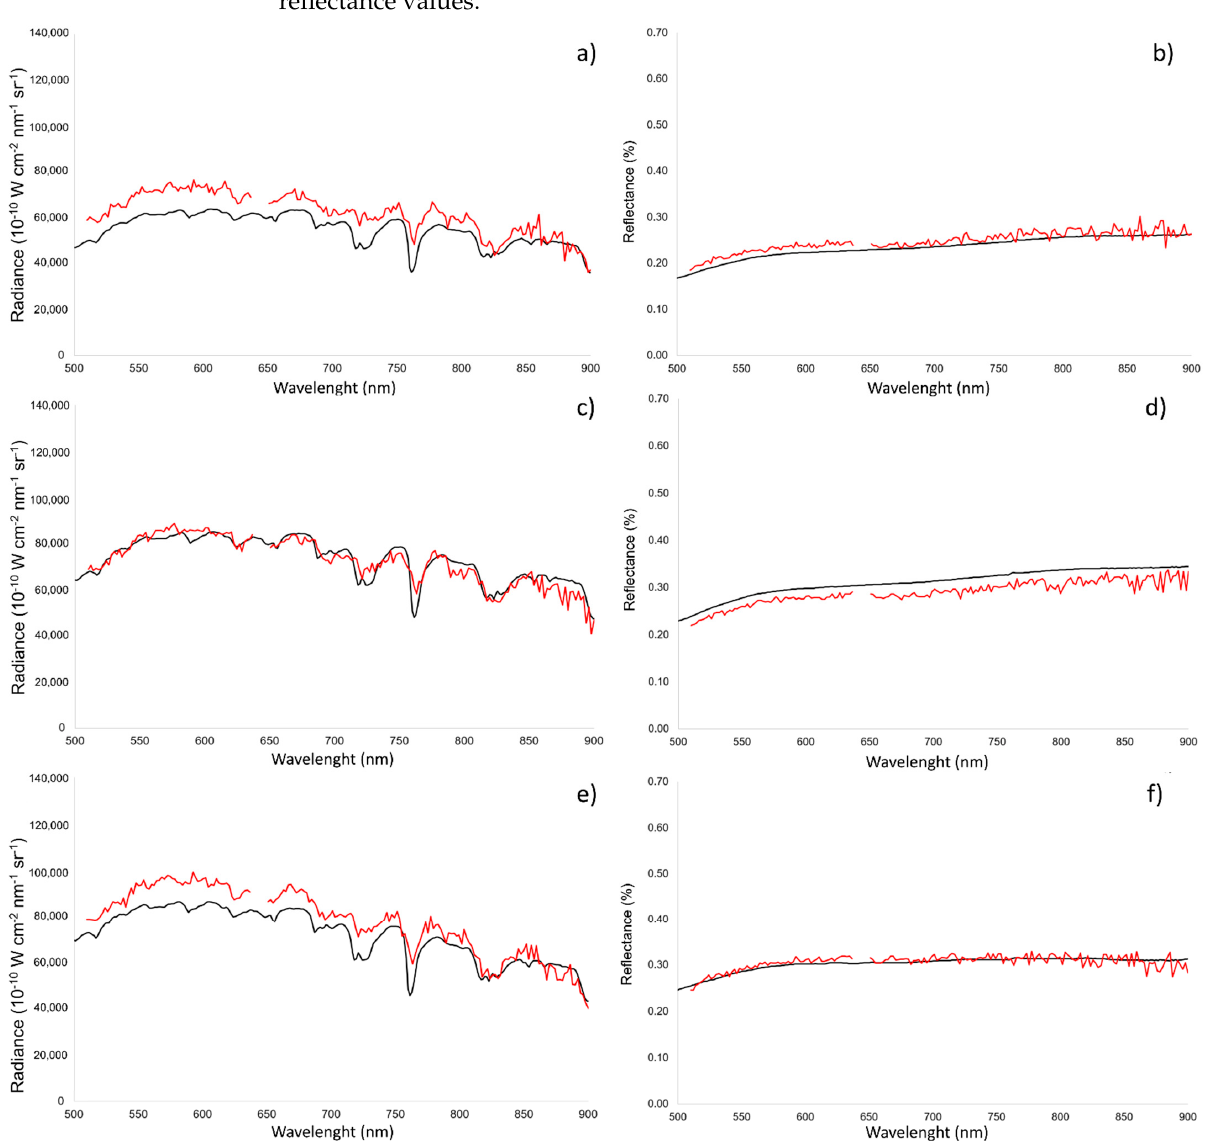
Figure 6. Comparison between GER 3700 (black line) and SENOP HSC-2 (red line) spectral signature in radiance and reflectance of bare soil ( a , b ), bare-stony soil ( c , d ) and stony soil ( e , f ) targets.